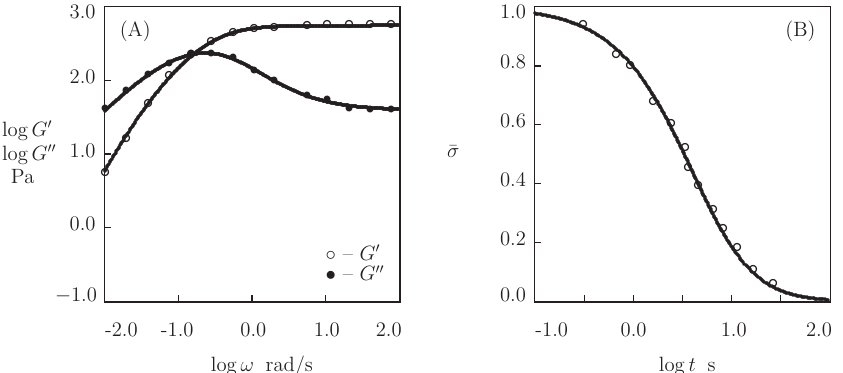
Figure 7. ( A )–Storage modulus G (cid:48) and loss modulus G (cid:48)(cid:48) versus frequency ω . Symbols: experimental data [71] on peptide-functionalized PEG gel. Solid lines: results of simulation. ( B )–Normalized stress ¯ σ = σ ( t ) / σ ( 0 ) versus relaxation time t . Circles: experimental data. Solid line: the prediction of the